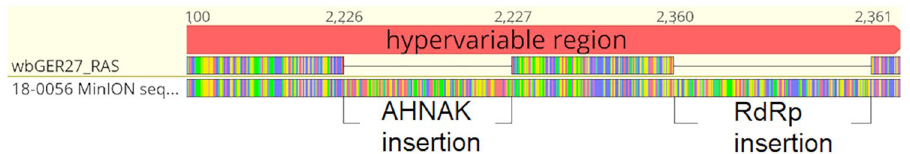
Figure 2. Cumulated AHNAK- and RdRp-derived Insertions in the HVR. The red bar represents the sequence annotation. Reference sequence is wbGER27_RAS (FJ705359.1) and below the sequence containing two insertions (AHNAK and RdRp) detected in sample 18-0056 ( sample 2 ) using long-read sequencing. Visualization of data by Geneious version 11.1.5 (Biomatters Ltd, Auckland,